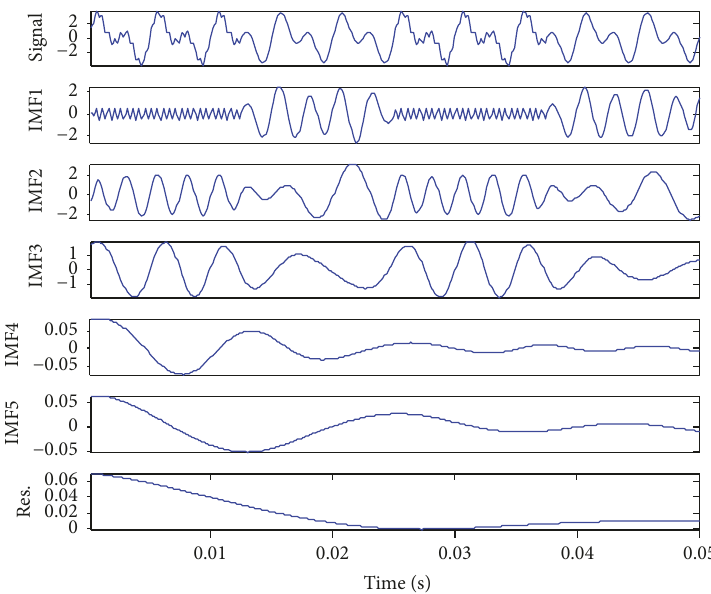
Figure 3: The decomposition results of EMD.